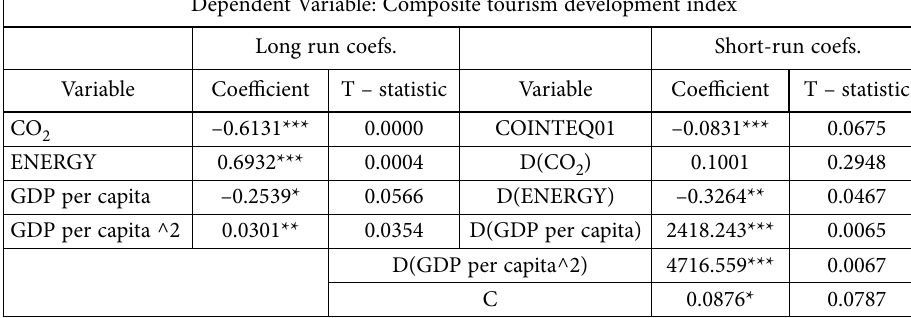
Table 9. Panel ARDL model estimations (source: own computations using EViews